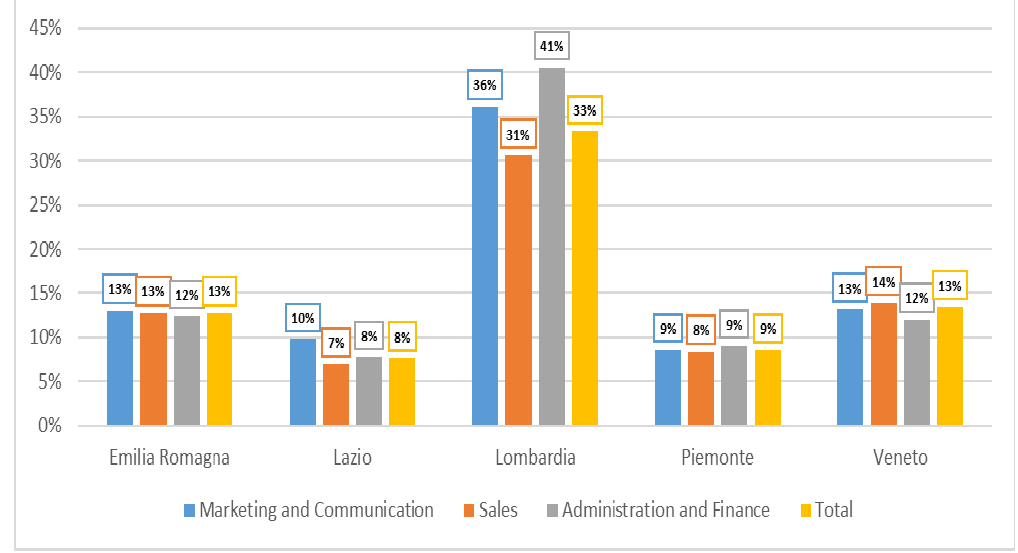
Figure 6: Geographical Location of Vacancies by Area and